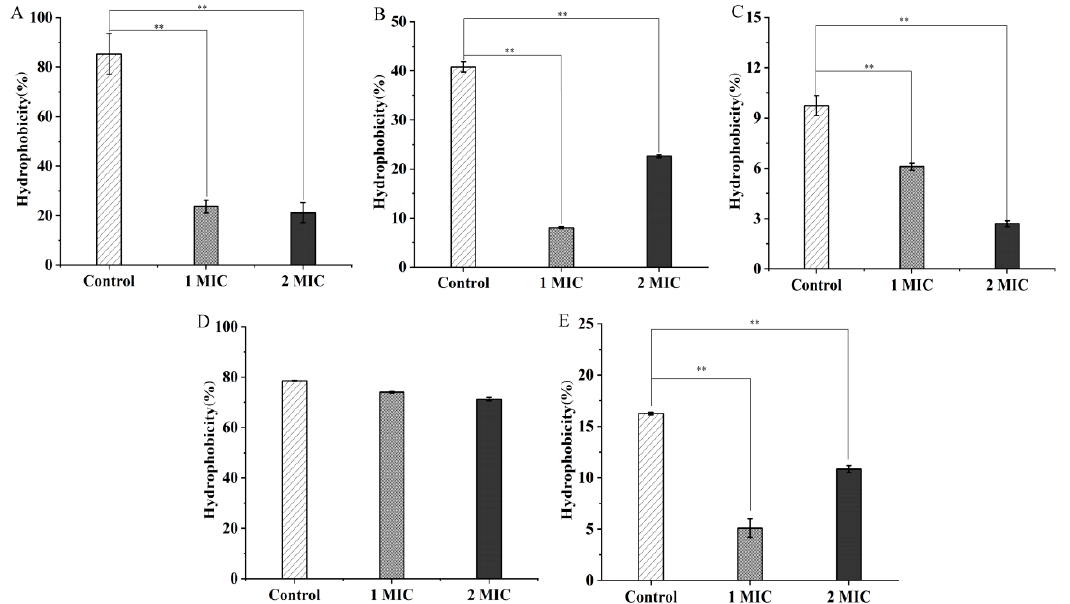
Figure 1. The effects of the GMPE on bacterial cell-surface hydrophobicity. ( A – E ) S. aureus ATCC8095, A. hydrophila, E. sakazakii CMCC45401, V. metschnikovii ATCC700040, and V. parahaemolyticus ATCC17802, respectively. **: p < 0.01.